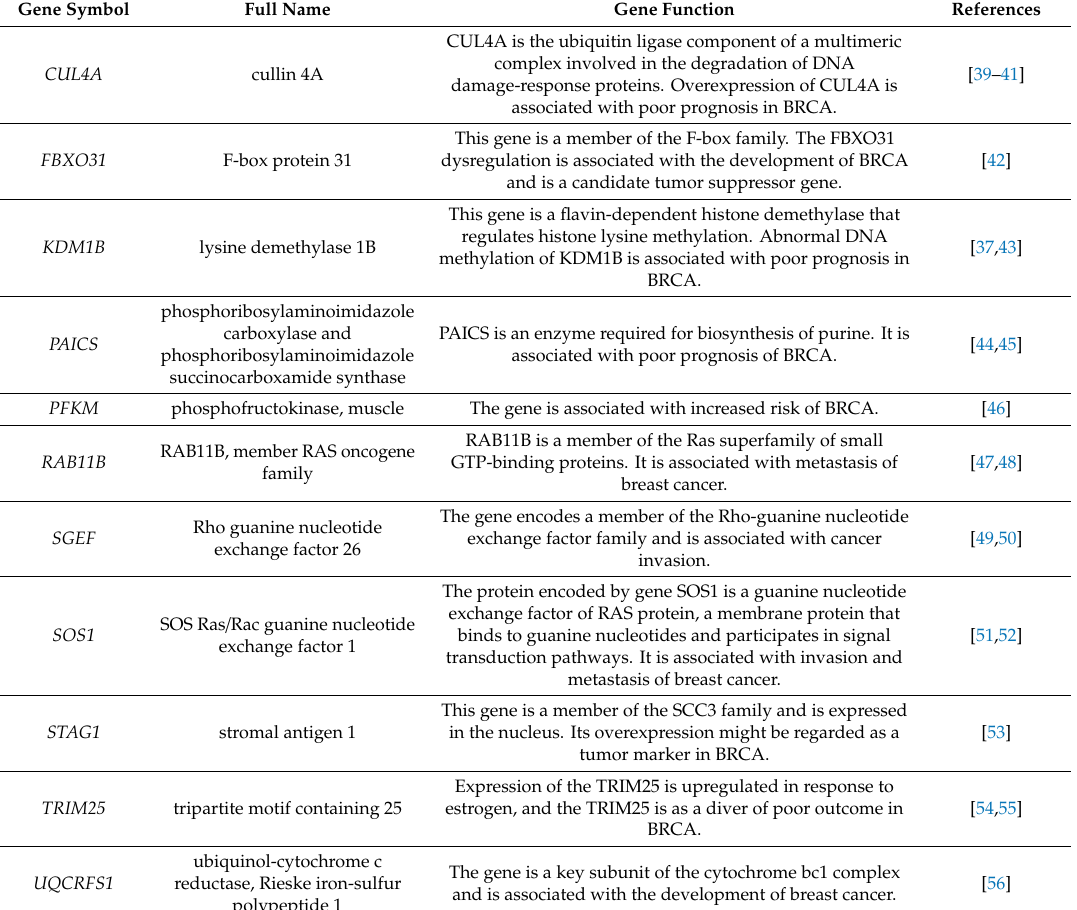
Table 1. Known genes associated with breast invasive carcinoma development, metastasis, and prognosis in the core module